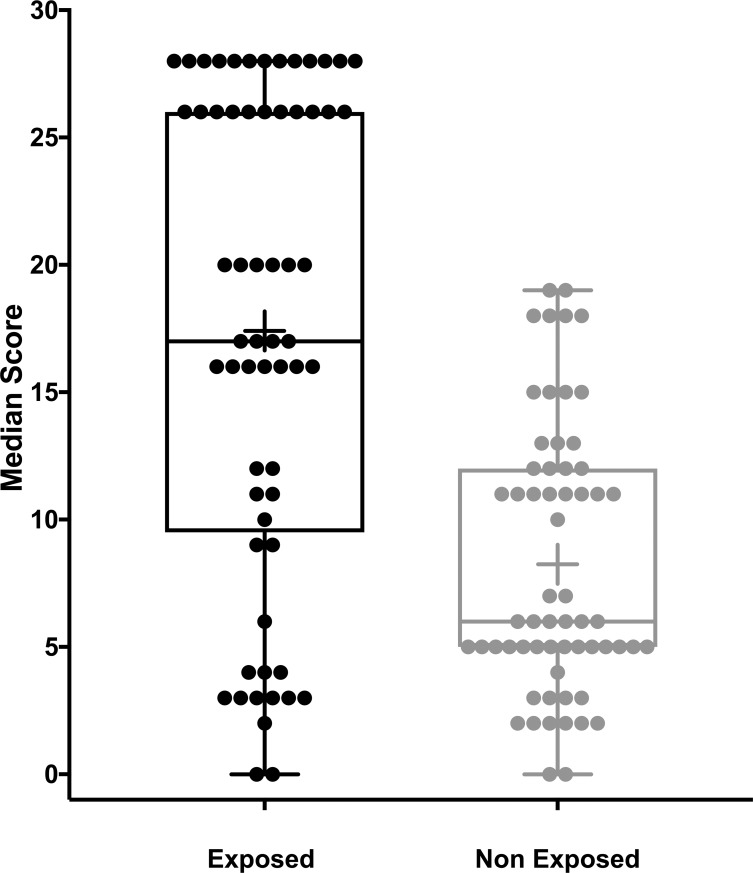
A box and whisker plot of the total score from the Donate questionnaire for exposed and non-exposed groups.Percentage of dry eye symptoms associates to the ocular Surface changes reported by the exposed and non- exposed groups to organic solvents used in the dry cleaning.